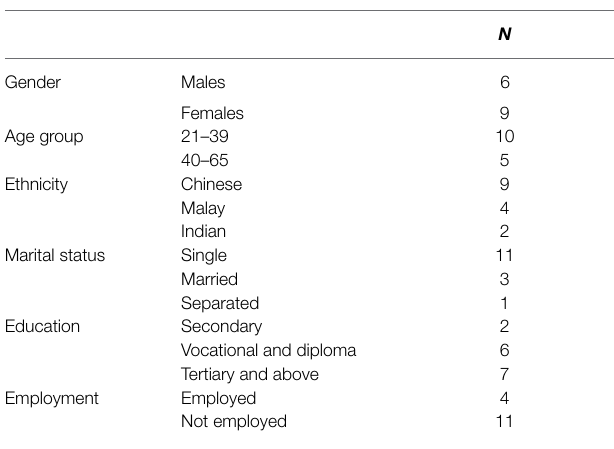
TABLE 1 | Profile of participants ( n =